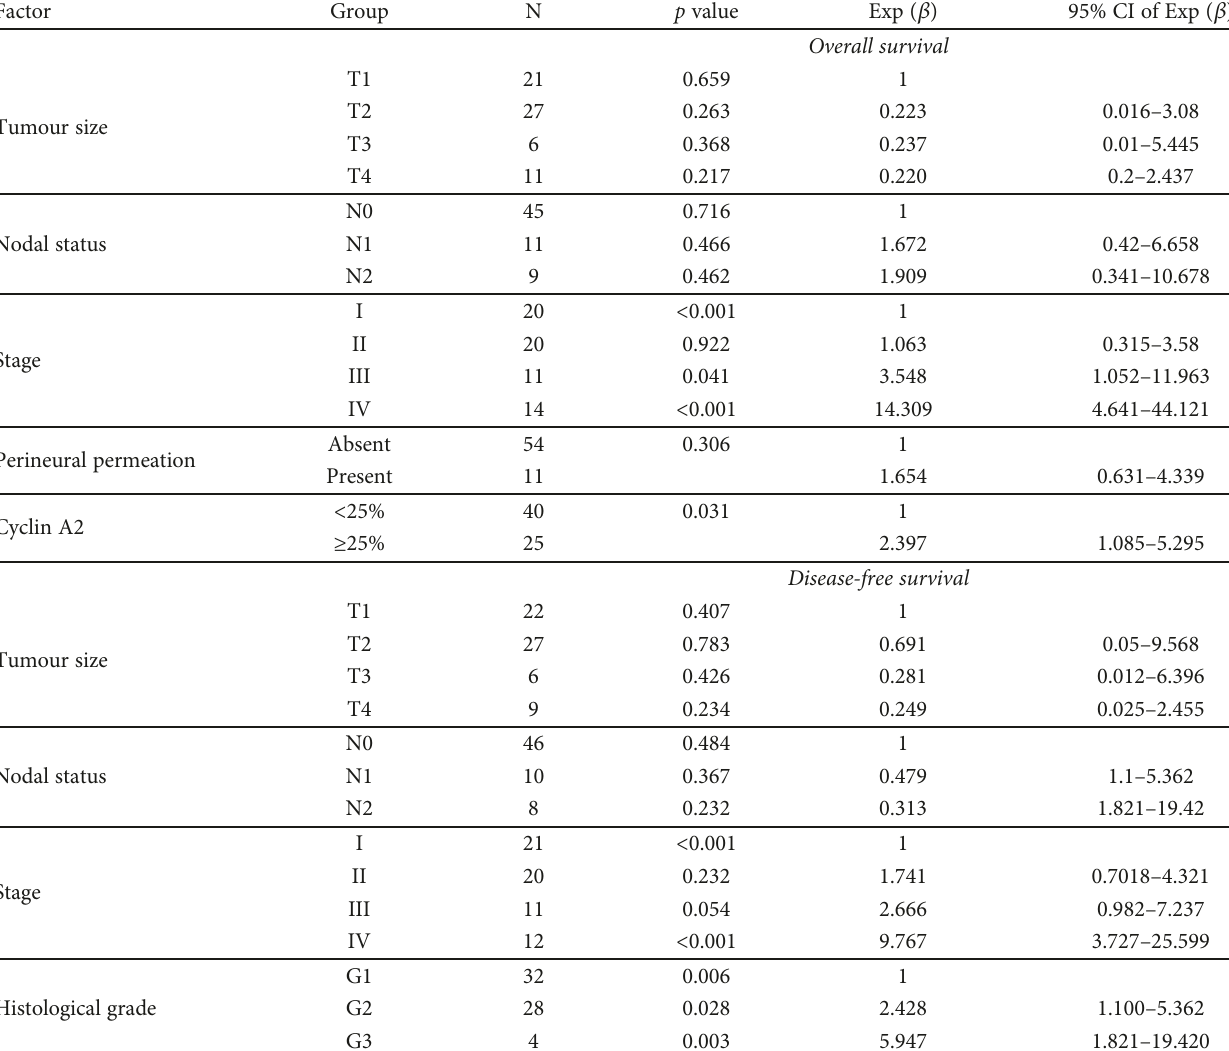
Table 4: Variables included in the multivariate Cox regression analysis of overall survival and disease-free